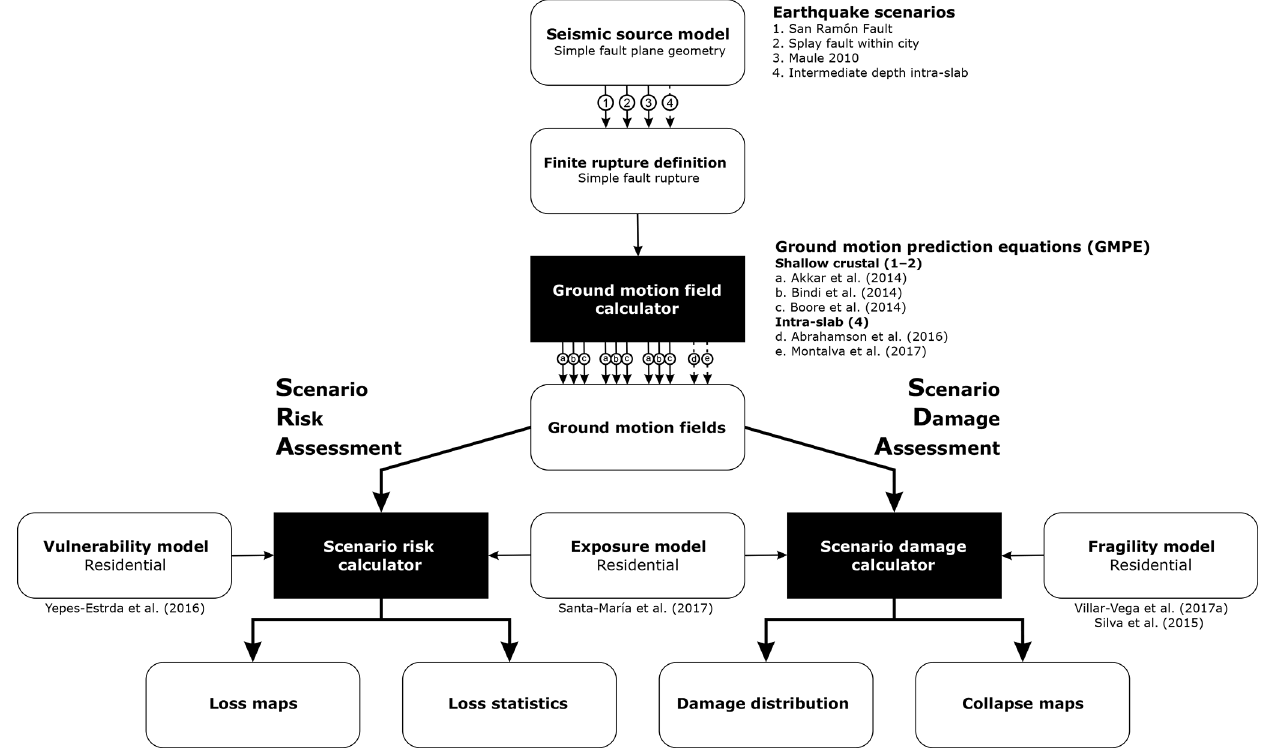
Figure 6. A graphical representation of the damage and loss calculation workflow using the Global Earthquake Model’s OpenQuake Engine (Silva et al., 2014). Black boxes represent model calculators, while white boxes are data